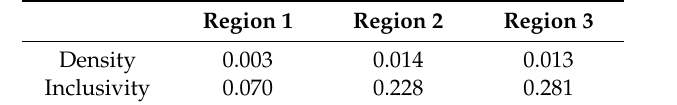
Table 3. CNA measures of global visibility network.